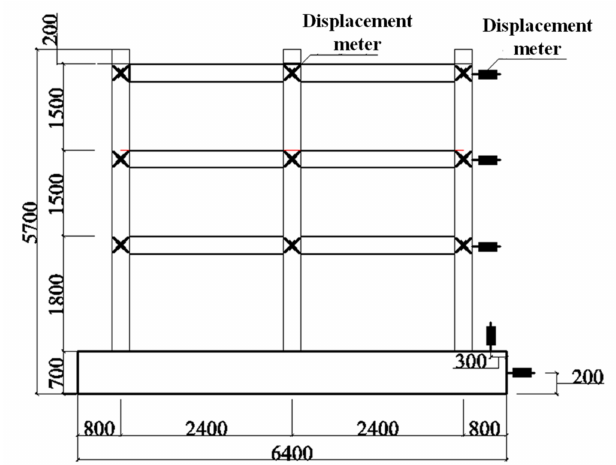
Figure 4. Positions of displacement meters.